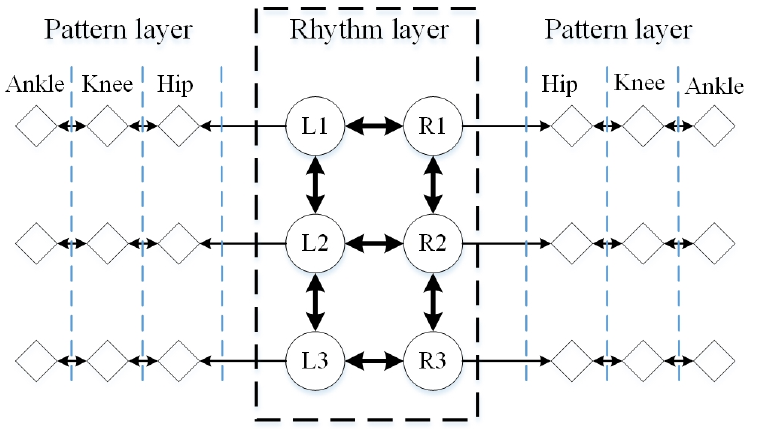
Figure 2. The hierarchical scheme of the proposed double-layered CPG network. The Kuramoto model is used as the mathematical model of CPG neurons in this paper. The neurons in the rhythm layer only determine the phase relations of legs. The mathematical model of CPG neurons in the rhythm layer is as follows [38]: